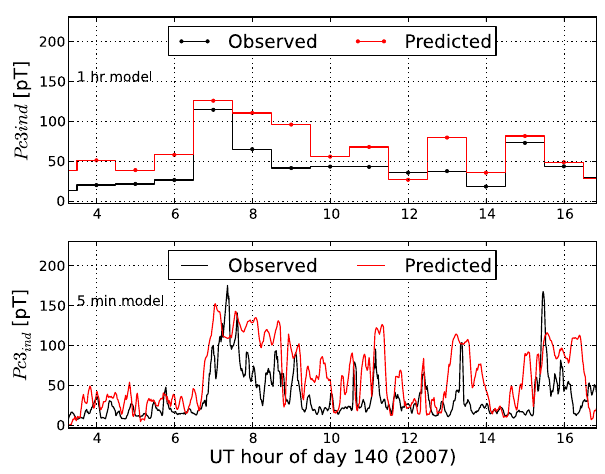
Figure 5. Measured and predicted Pc3 ind from the low-resolution (1h) and the high-resolution (5min)